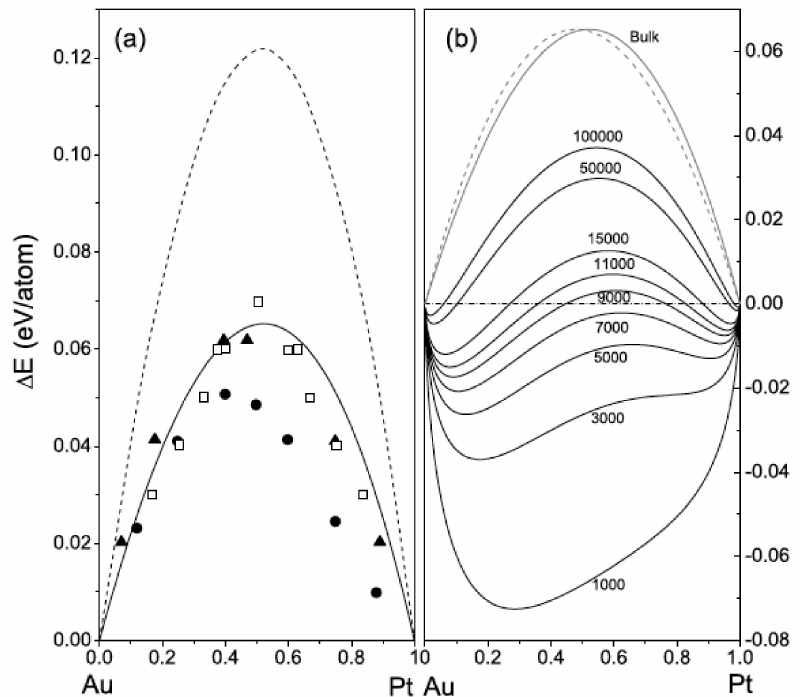
Figure 12. ( a ) The enthalpy of mixing for the bulk Au-Pt system, calculated using an embedded atom method as a function of Pt concentration, showing the expected peak at Au 50 Pt 50 (solid line). The other data are previous calculations using an EAM model (dashed line), an LMTO model (full circles) and the Miedema theory (open squares) as well as experimental data (full triangles). ( b ) Size and composition dependence of the enthalpy of mixing, showing a transition to negative values in the 50/50 mixture for particle sizes below 7500 atoms (6.2 nm). At low Pt concentrations, the critical size is larger. Reproduced with permission from